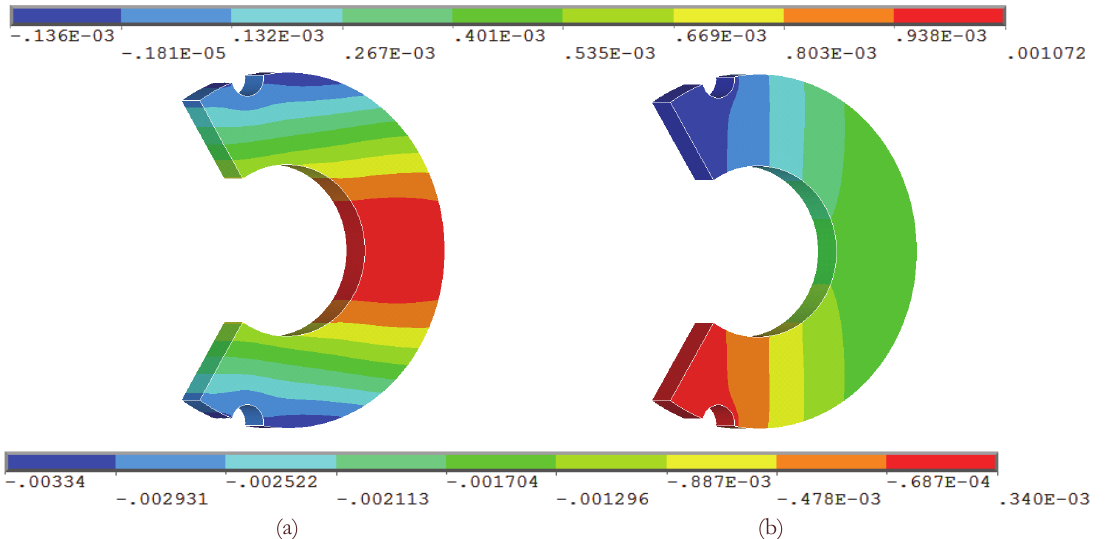
Figure 10: The distribution of the (a) horizontal- ( u x ≡ u , upper scale) and the (b) vertical- ( u y ≡ v , lower scale) displacement components for a CSR with ρ =2.0 for a common externally imposed displacement equal to 3.0 mm (scales in m).